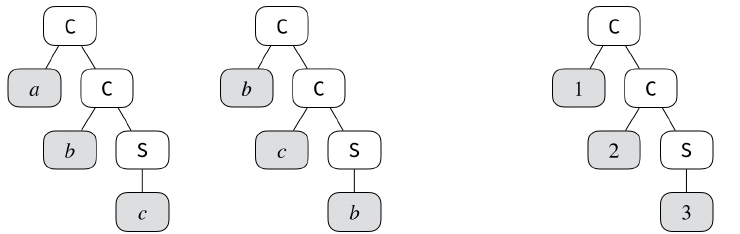
Figure 2. Two lists over X = { a , b , c } ( left ) and their common index representation ( right